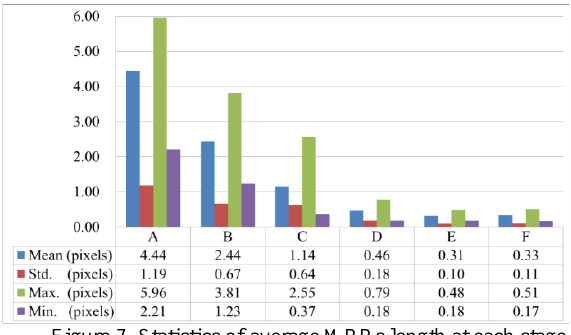
Figure 7. Statistics of average MRRs length at each stage